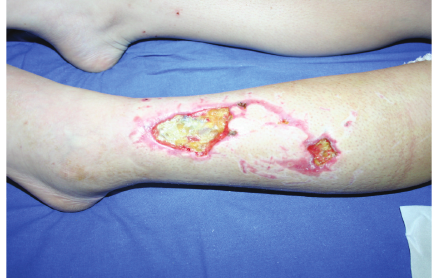
Figure 1: Leg ulcer before any treatment.